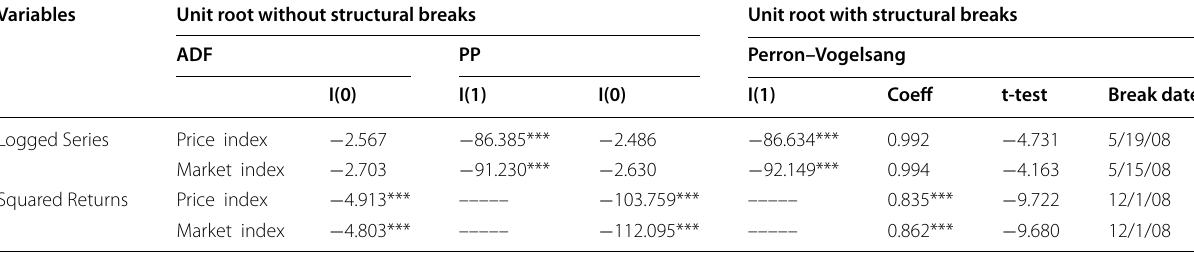
Table 2 Unit root tests